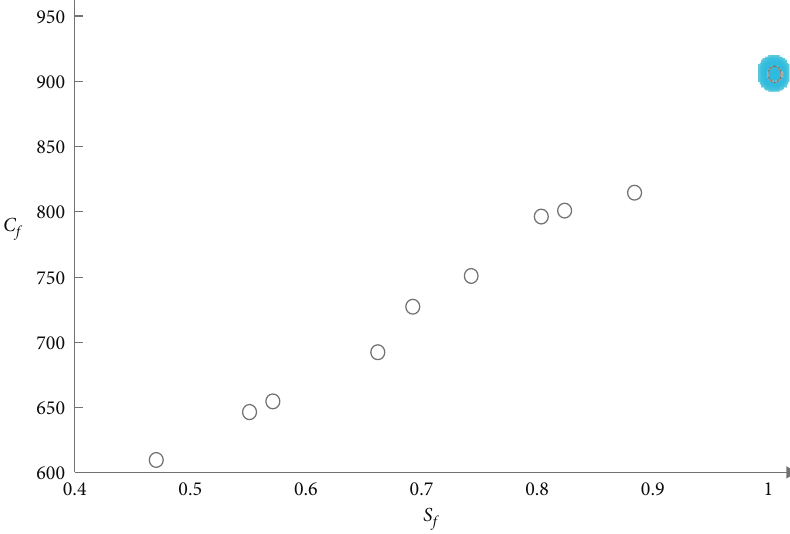
Figure 5: Noninferior solution set of example R105.